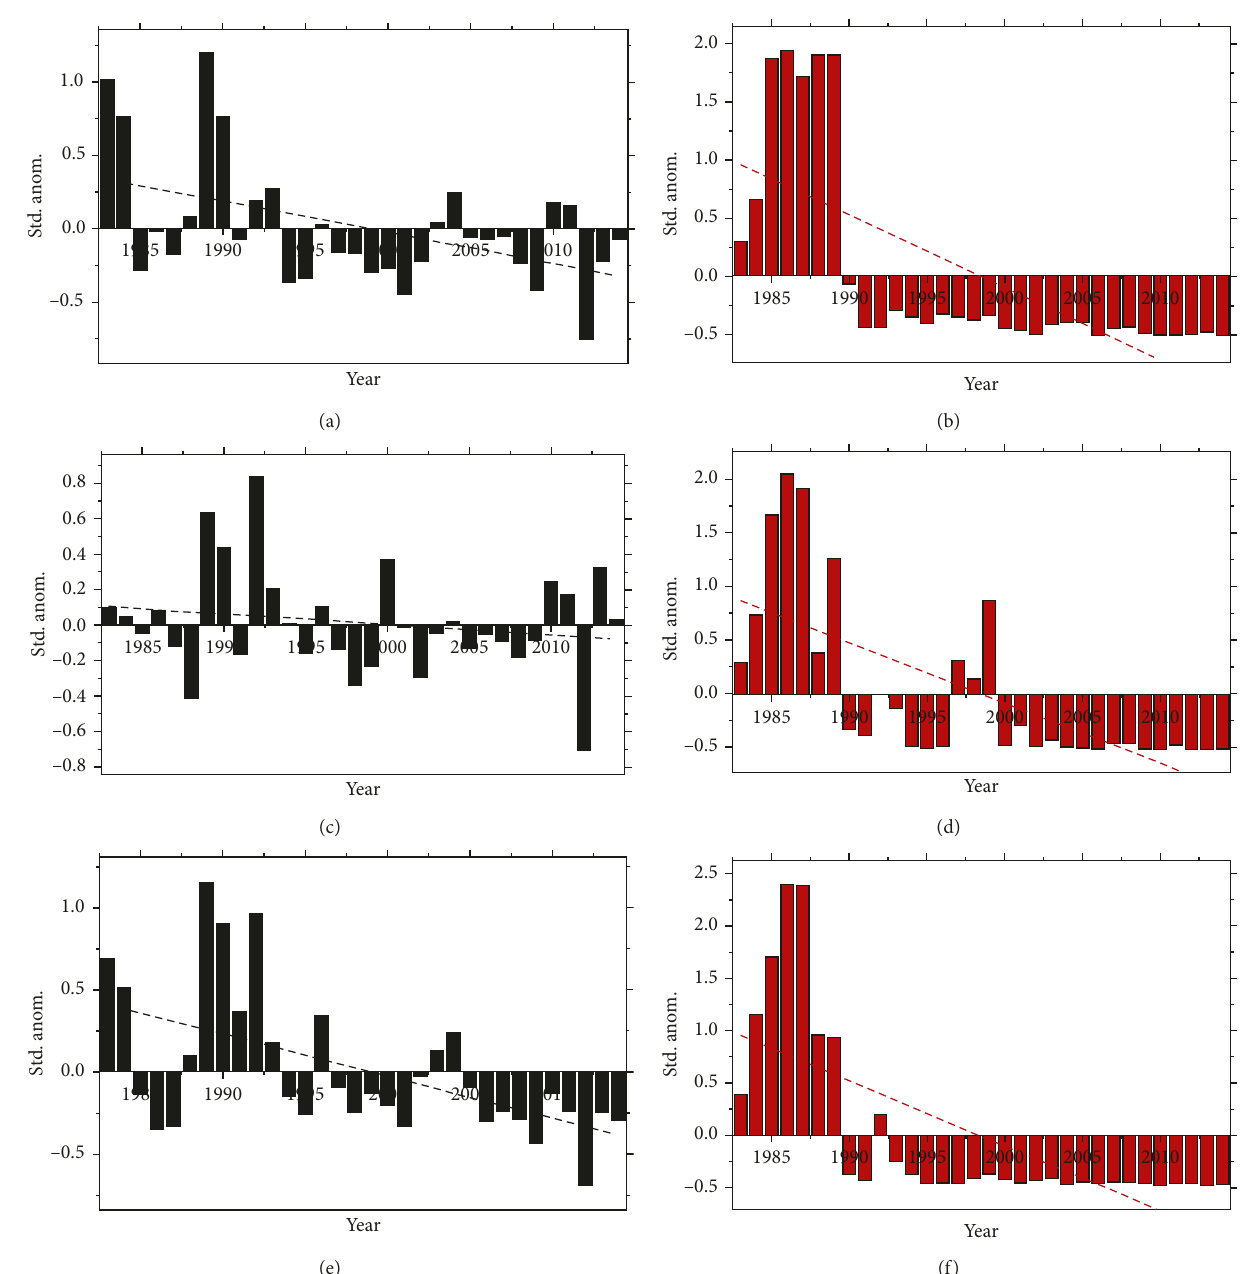
Figure 3: Standardized anomalies of cool days (TX10p) over three agroecological zones, (a) lowland, (c) midland, and (e) highland, and for cool nights (TN10p), (b) lowland, (d) midland, and (f) highland, for the period